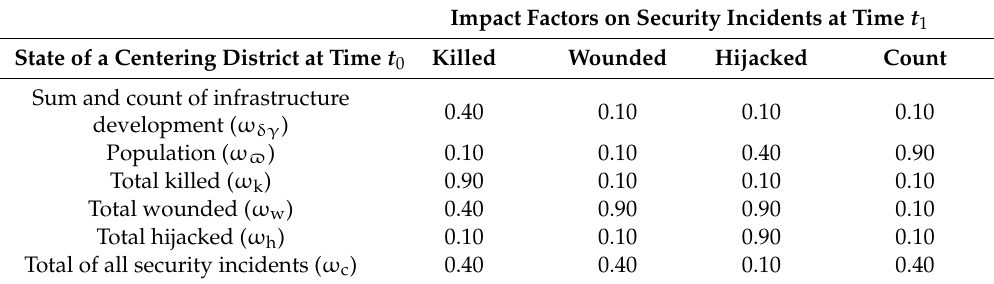
Table 1. Impact of centering cell states on security incidents.